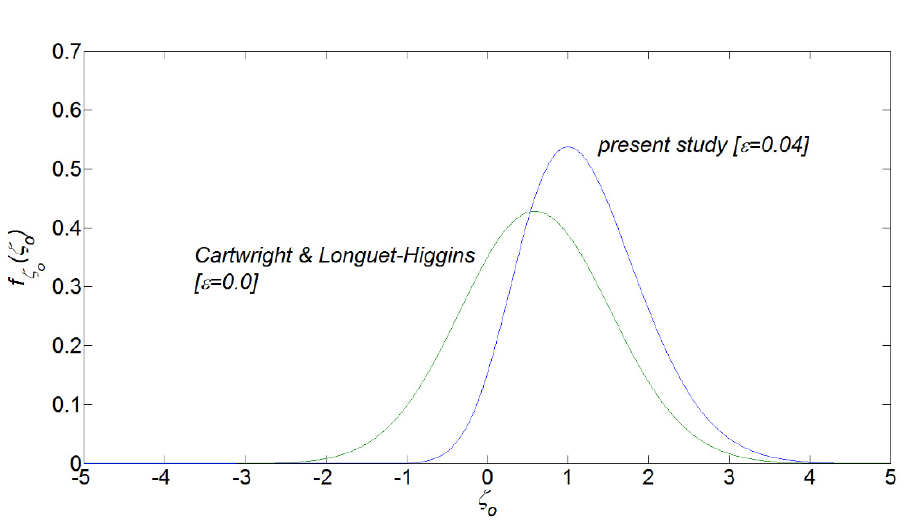
Figure 2. Measured wave spectra.